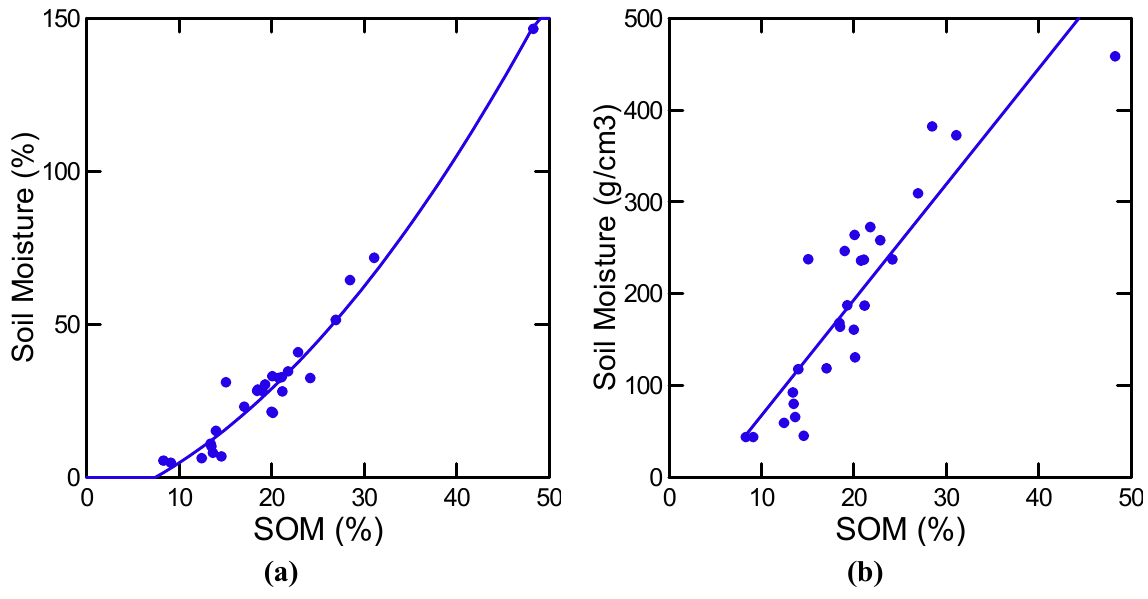
Figure 4. ( a ) The relationship between percent soil organic matter and percent soil moisture in the top 10 cm of mineral soil; ( b ) The relationship between percent soil organic matter and soil moisture content in the top 10 cm of mineral